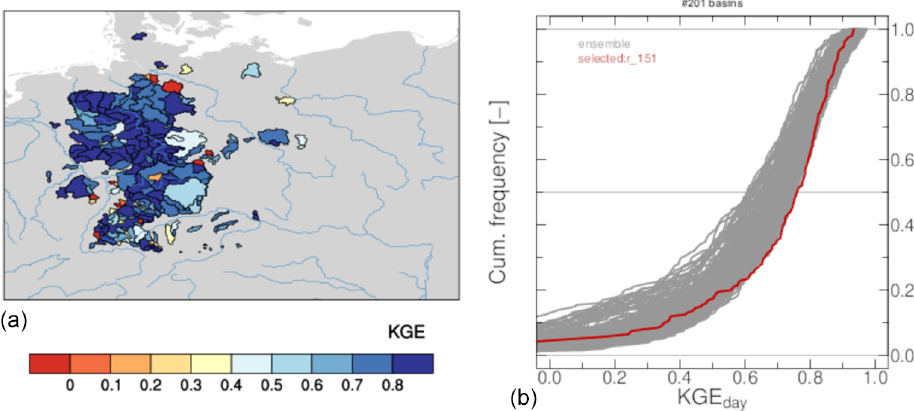
Figure A1. Results of mHM multi-basin model calibration based on streamflow data from 201 catchments. (a) Spatial map of KGE for each basin. (b) KGE cumulative density function of 200 parameter sets, generated by random sampling of the basins. Bold red marks indicate the selected parameter set.